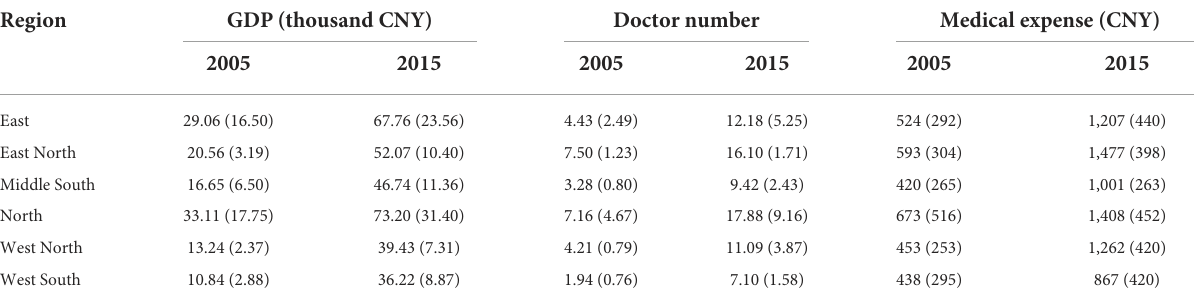
TABLE 4 Summary information for medical care and economic status in different regions.